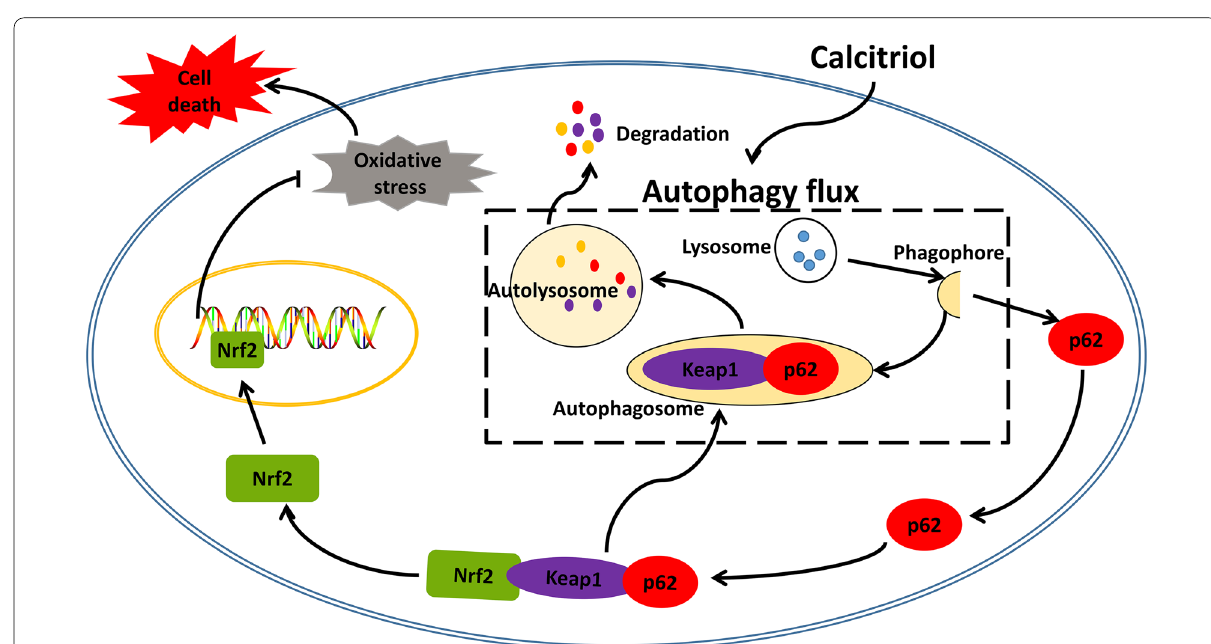
Fig. 9 The molecular mechanisms underlying the neuroprotective effects of calcitriol against TBI. Calcitriol maintains redox balance and protects the brain from oxidative damage through Nrf2 signaling mediated by the autophagic degradation of